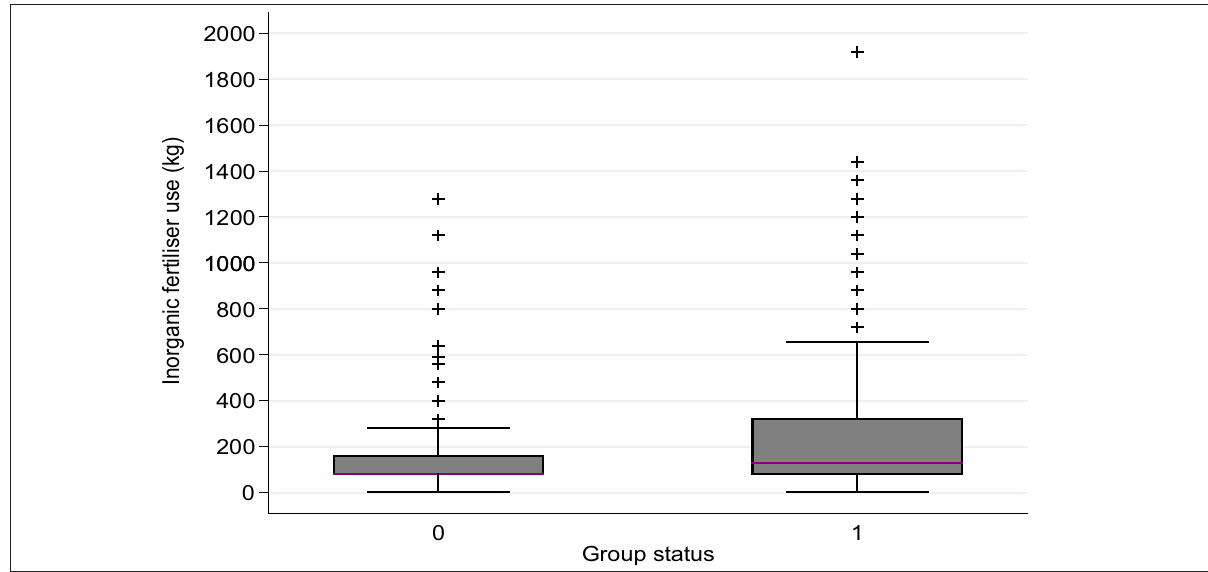
Figure 1: Box-and-whisker plots showing the quantity of fertiliser used by farmers according to group status: 0 indicates non-members and 1 indicates group members.